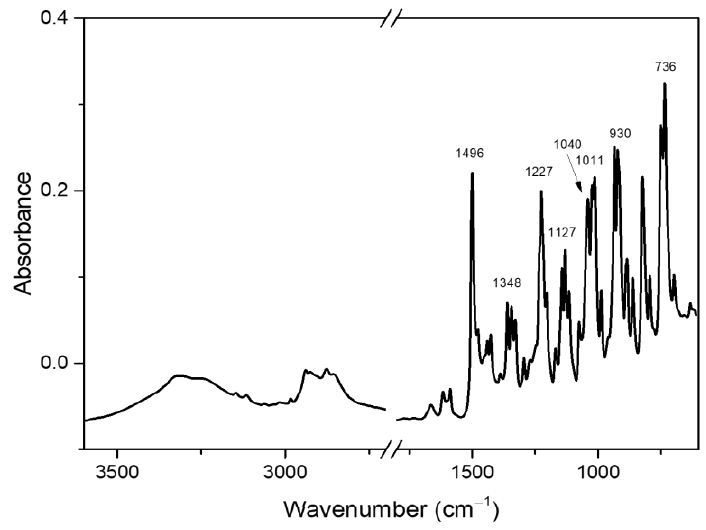
Figure 1. Fourier transform infrared (FTIR) spectrum for T–Fa.